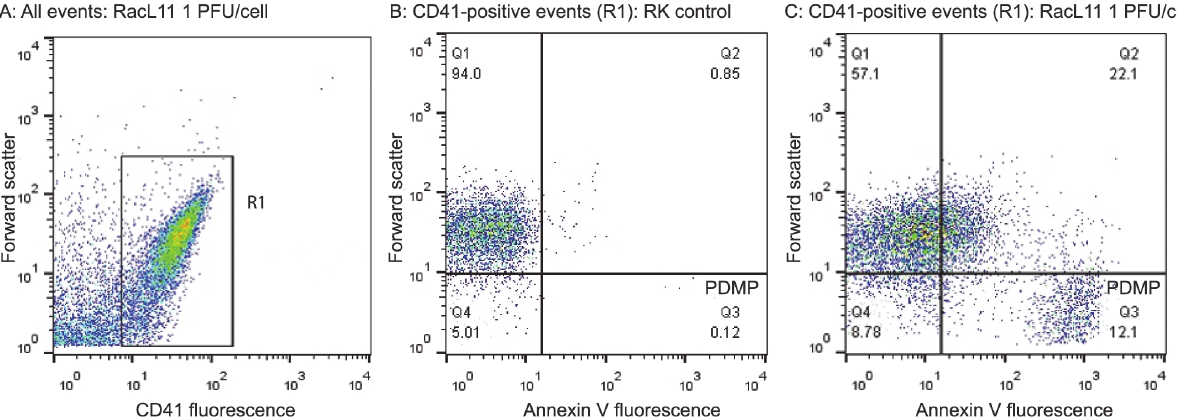
Fig 2. Flow cytometry gating strategy for quantification of platelet-derived microparticles in equine platelet samples. A: Platelet events in citrate- anticoagulated platelet-rich plasma were identified and gated as CD41-positive cells (R1 region) in a CD41 fluorescence versus forward scatter (FSC) dotplot. The R1 region or gate was established on an isotype control for the CD41 antibody. Representative image from platelets exposed to the RacL11 strain of EHV-1 at 1 plaque forming unit (PFU)/cell. B: Platelet-derived microparticles (PDMPs) were defined as small events ( < 10 1 log FSC units) positive for Annexin V and CD41. The PDMP percentage was obtained from the lower right quadrant of an Annexin V fluorescence versus FSC dotplot of the R1 gate (CD41-positive events), with the quadrants being defined on a negative sample in which 1 mM EDTA was added to the buffer with Annexin V. The PDMP percentage was 0.1% in this representative image of platelets exposed to rabbit kidney 13 (RK) cell lysate at an equivalent volume to 1 PFU/cell (mock- infected negative control). The events in the upper left and right quadrants are platelets that are negative (94.0%) and positive for Annexin V (0.9%), respectively. C : Representative image of PDMP quantification in platelets exposed to RacL11 at 1 PFU/cell. In this sample, there are 12.1% PDMP (lower right quadrant) and 22.1% of platelets are weakly positive for Annexin V (upper right quadrant).